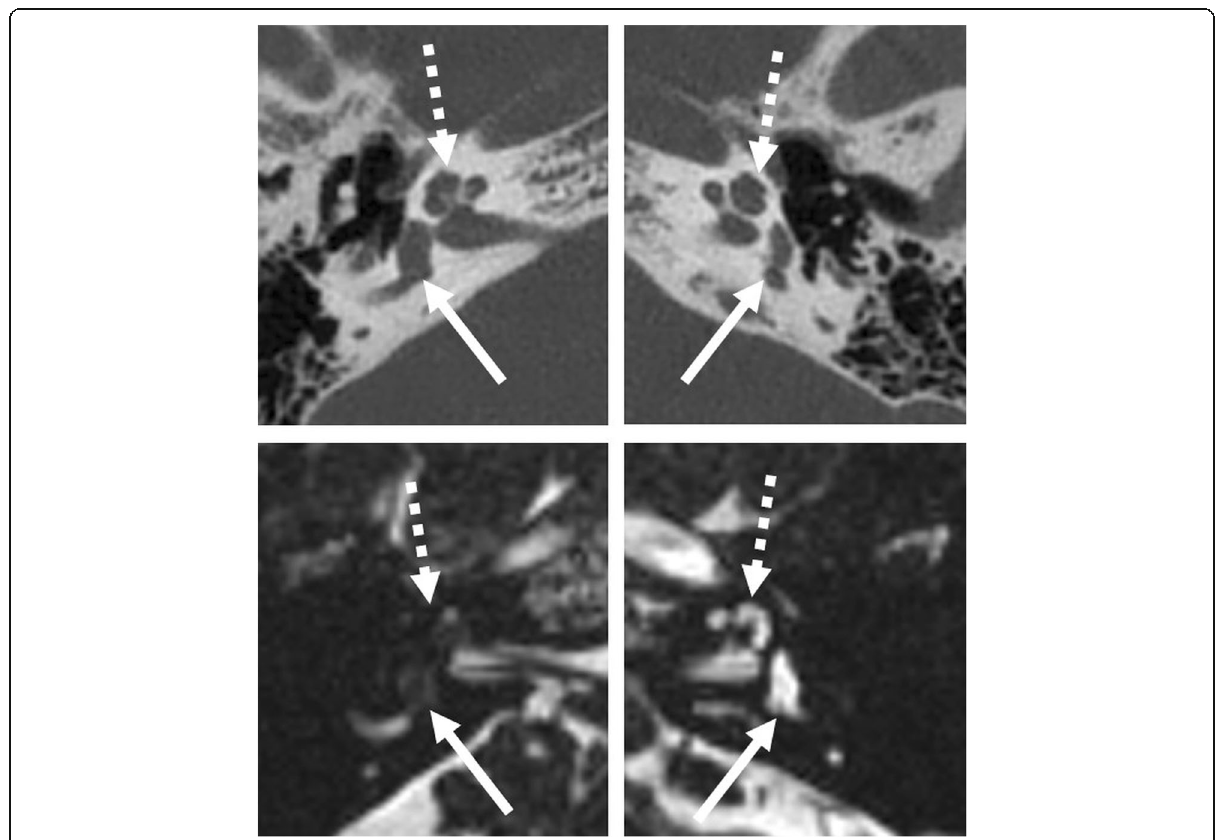
cochlea (dashed arrow) and vestibulum (arrow), compatible with fibrosis in early-stage labyrinthitis ossificans